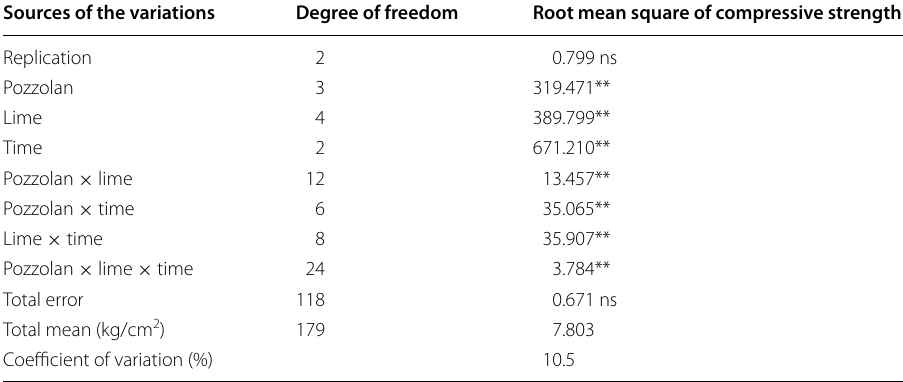
Table 6 Results of variance analysis of effects of pozzolan, lime and curing age on uncon- fined compressive strength